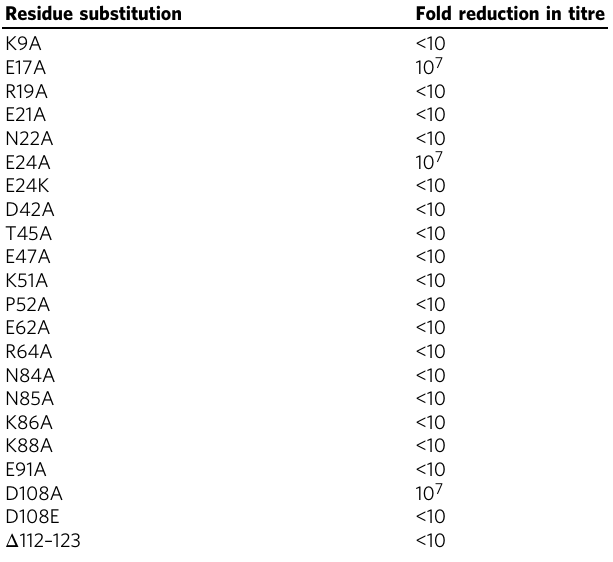
Table 2 In vivo phage plaquing